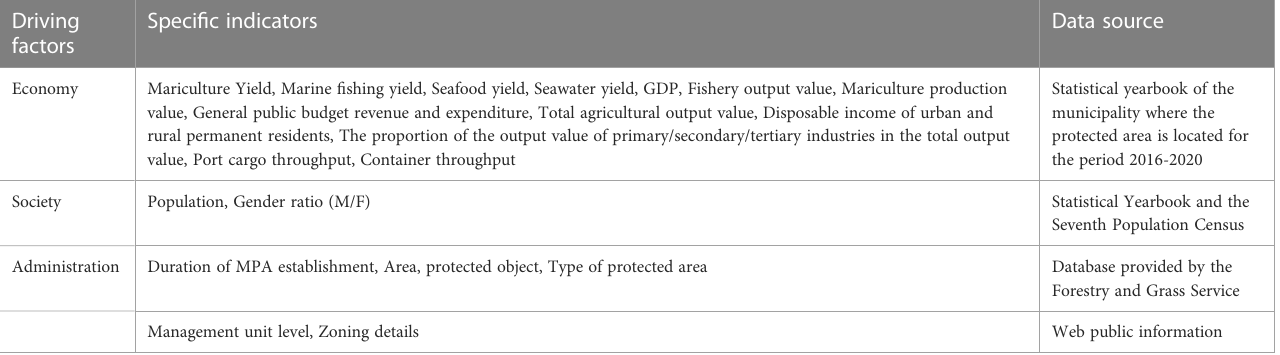
TABLE 5 Potential drivers affecting management effectiveness.